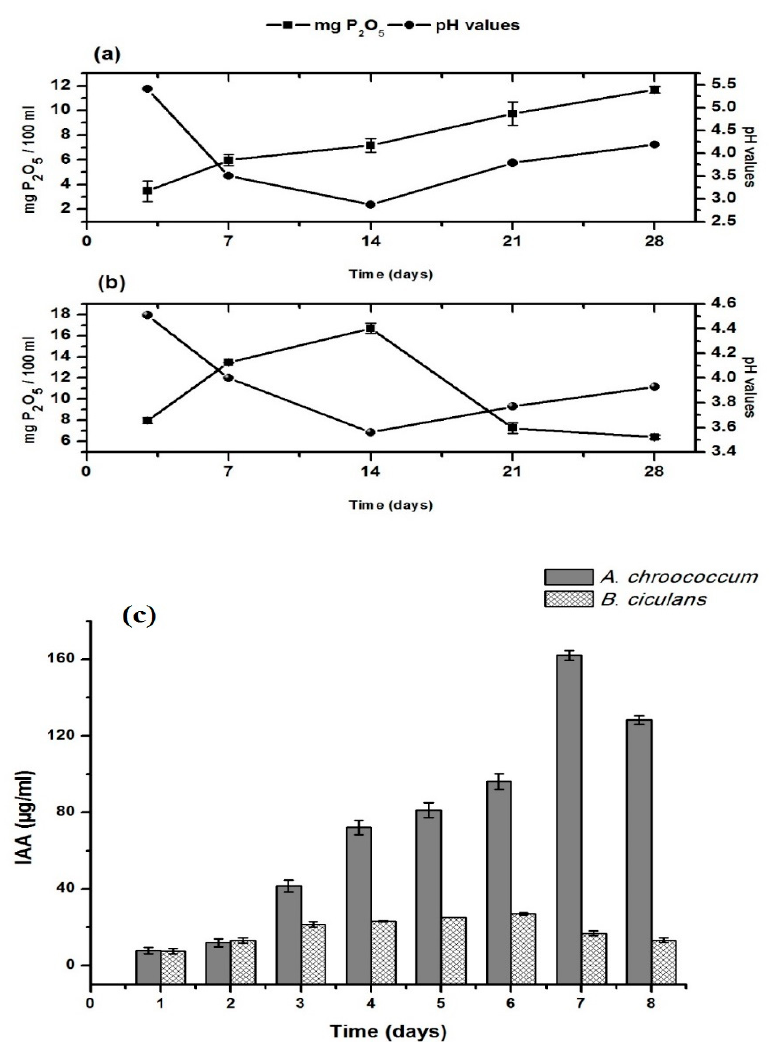
Figure 1. Phosphate solubilization by the bacterial strains; ( a ) A. chroococcum SARS 101, ( b ) B. circulans ARC-SWERI-2; and ( c ) Indole acetic acid production by A. chroococcum SARS 101 and B. circulans ARC-SWERI-2.